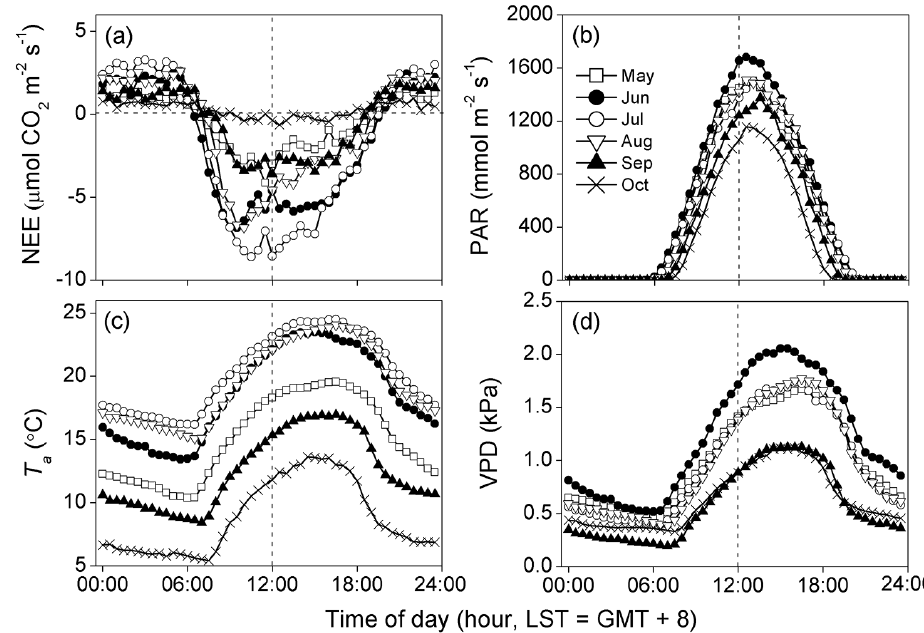
Figure 10. Monthly mean diurnal cycles of net ecosystem CO 2 exchange (NEE) (a) , incident photosynthetically active radiation (PAR) (b) , air temperature (T a ) at 6m above ground (c) and vapor pressure deficit (VPD) (d) . The vertical dashed lines indicate noon, and the horizontal dashed line in (a) represents y =